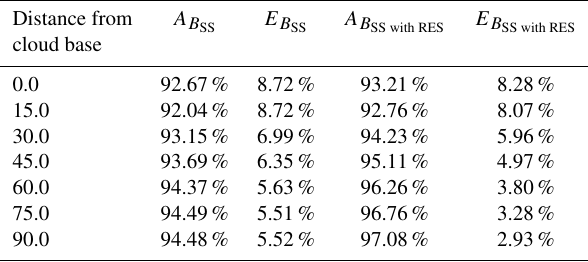
Table 1. Mean error and accuracy of the cloud optical thickness ex- tinction retrieval for different heights above the cloud base. Data are retrieved by inverting the simulated single scattering signal ( B SS ) with the α (cid:48) estimate calculated from Eq. (7). Results from two 0 inversions are presented, i.e. one without any correction and one with the application of the resolution correction calculated from Eqs. (12)–(14) (noted with the subscript